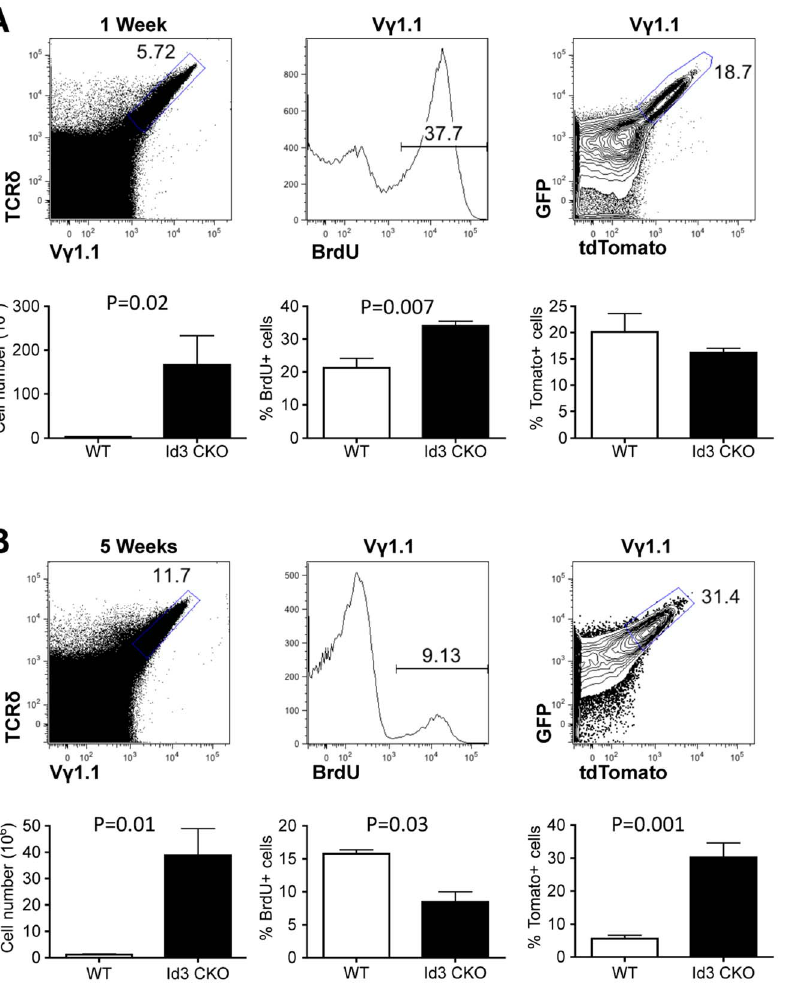
Figure 4. Assessing proliferation frequency and history of V c 1.1 T cells on Id3 deficient background. (A) Analysis of V c 1.1 T cells in one week old LckCre;Tolx;Id3 f/f thymus. V c 1.1 T cells were first gated from analysis of total thymocytes (left) and then displayed for BrdU incorporation (middle) and tdTomato expression (right). Below each FACS plot is statistic analysis against Id3 wild type samples described in Fig. 3. Four wild type and seven Id3 mutant samples were used in the unpaired student t-test. (B) Analysis of V c 1.1 T cells in five week old LckCre;Tolx;Id3 f/f thymus. Sample display is as in (A). Student t tests were based on three wild type and three Id3 mutant samples for the left and center plot and five wild type and six Id3 mutant samples for the right